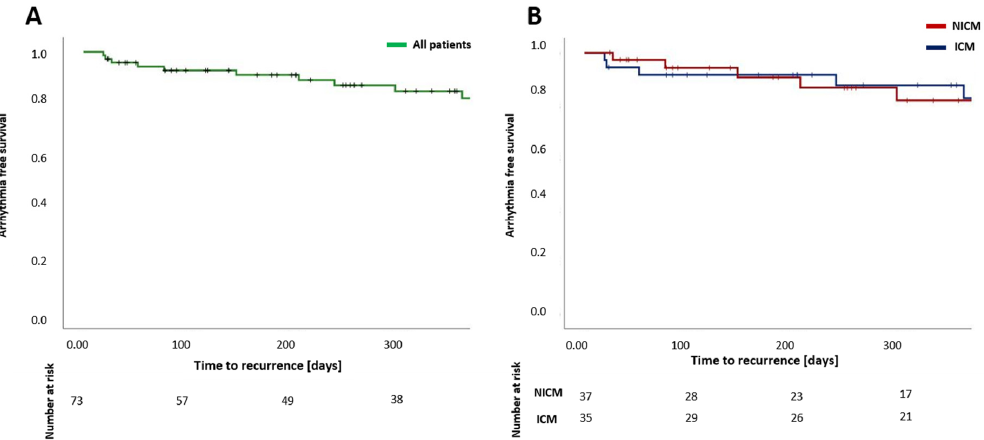
Figure 4. Estimation of arrhythmia-free survival after catheter ablation of ventricular arrhythmia for all patients ( A ) and for patients with ICM in comparison to patients with NICM ( B ) after a single procedure. NICM—nonischemic cardiomyopathy; ICM—ischemic cardiomyopathy.